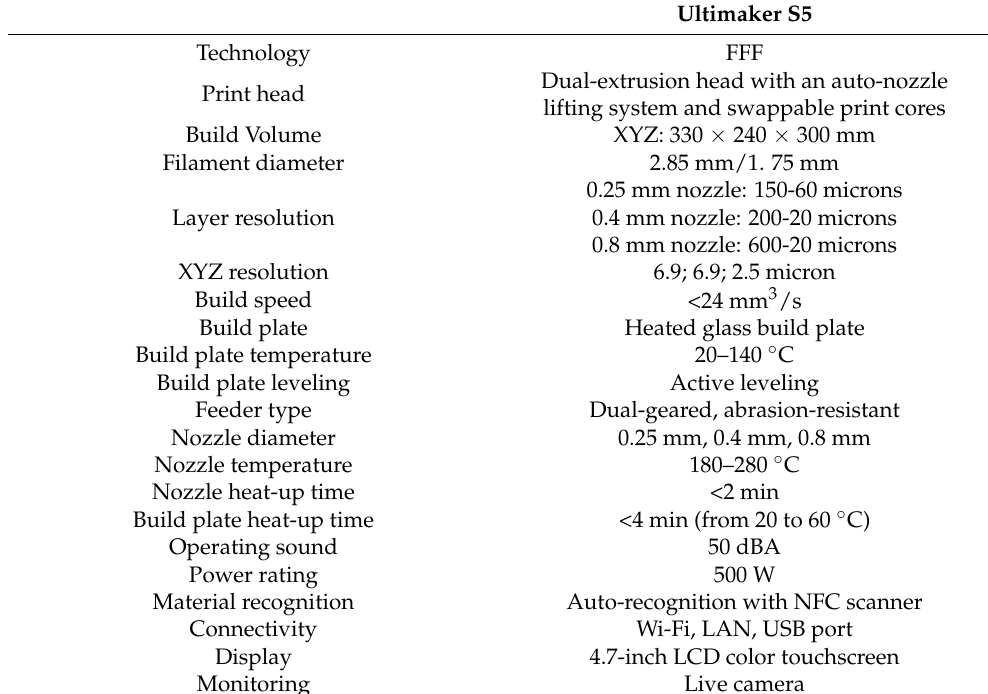
Table 2. Characteristics of the applied Ultimaker 3D printer.